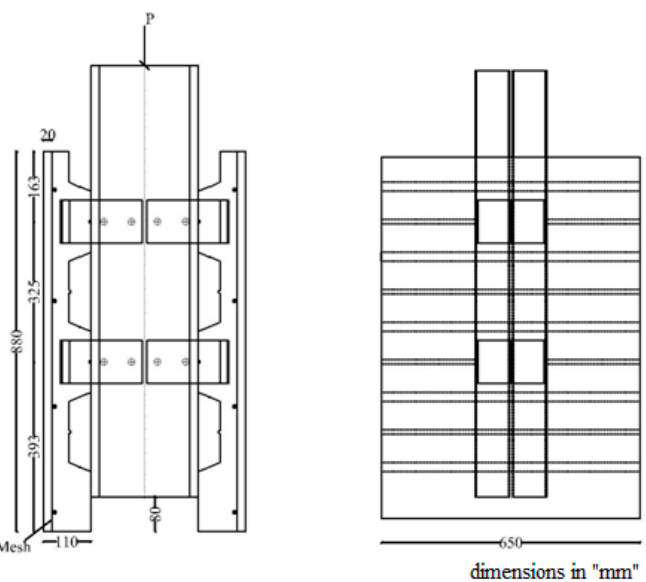
Figure 3. Test configuration for a DBSC250 specimen [21].